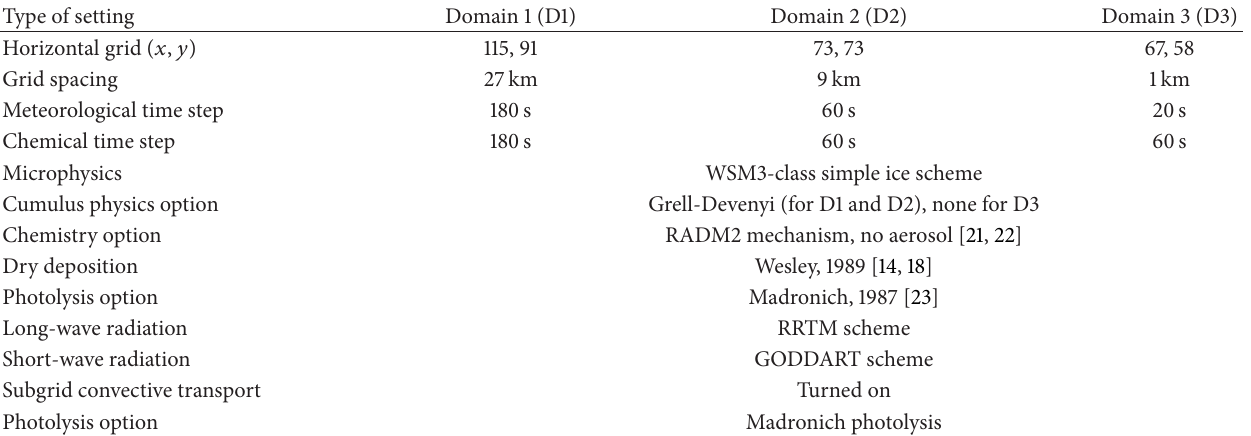
Table 2: Domain setting and selected configuration parameters for WRF-Chem model operation.